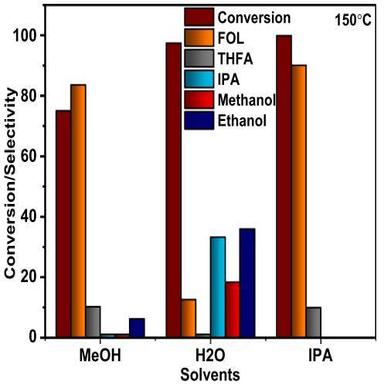
Effect of variation of solvent on conversion/selectivity.